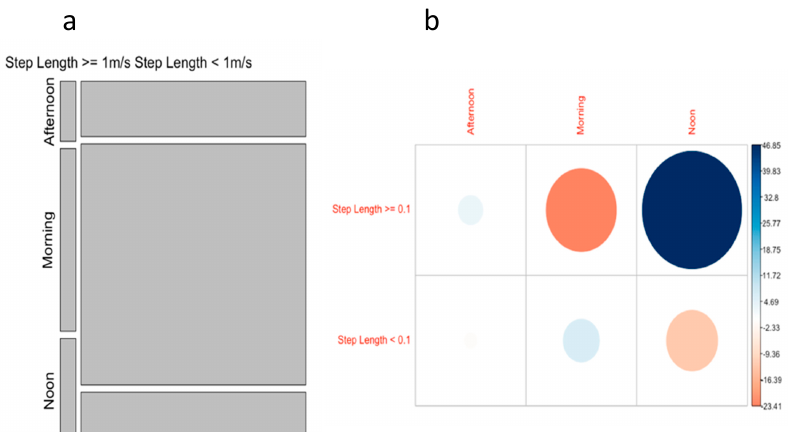
Figure 12. ( a ) A mosaic plot comparing proportions of step length above and below 1 m/s according to time of day. The ‘x’ axis compares the proportions of the total number of step lengths above and below 1 m/s for all times of day. The ‘y’ axis compares the proportion of total number of step lengths above and below 1 m/s for each time of day. ( b ) A balloon plot indicating the relationship between proportions of step length above and below 1 m/s according to time of day. The larger the circle and darker the color, the greater the residuals and the stronger the correlation. Blue represents a positive correlation, while red represents a negative